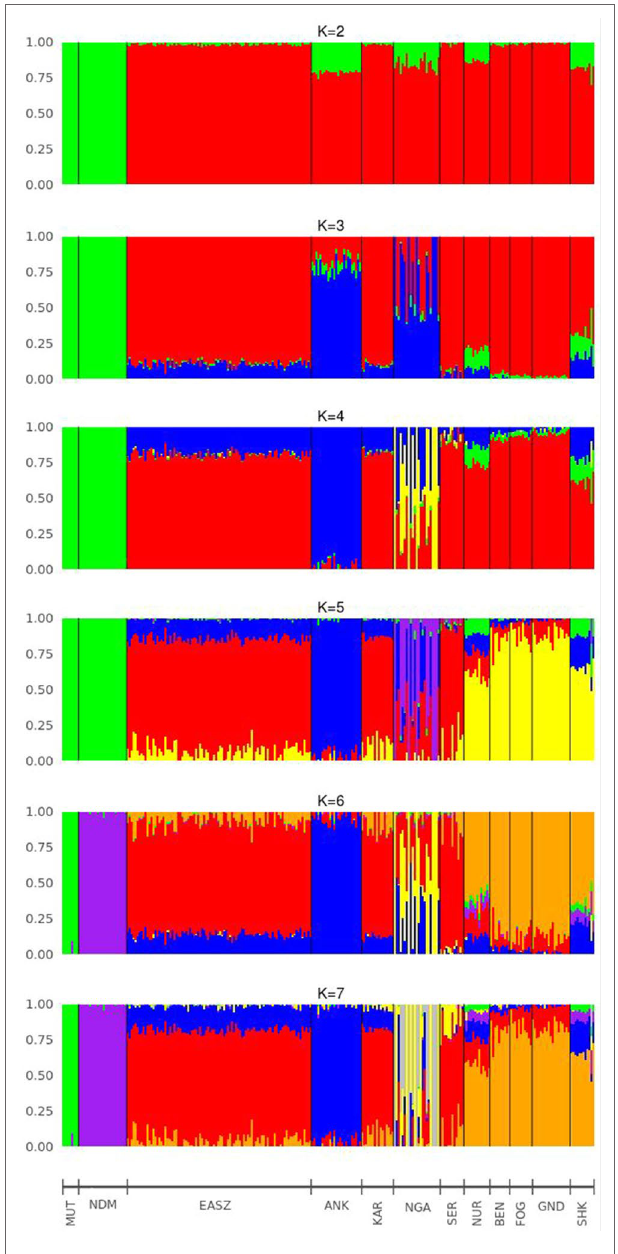
FIGURe 3 | Admixture bar plots of each individual assuming different numbers of ancestral breeds (K = 2 to K = 7). ANK, Ankole; BEN, Benshangul; FOG, Fogera; GND, Gindeberet; KAR, Karamojong; MUT, Muturu; NDM, N’Dama; NGA, Nganda; NUR, Nuer; SER, Serere; SHK, Sheko.